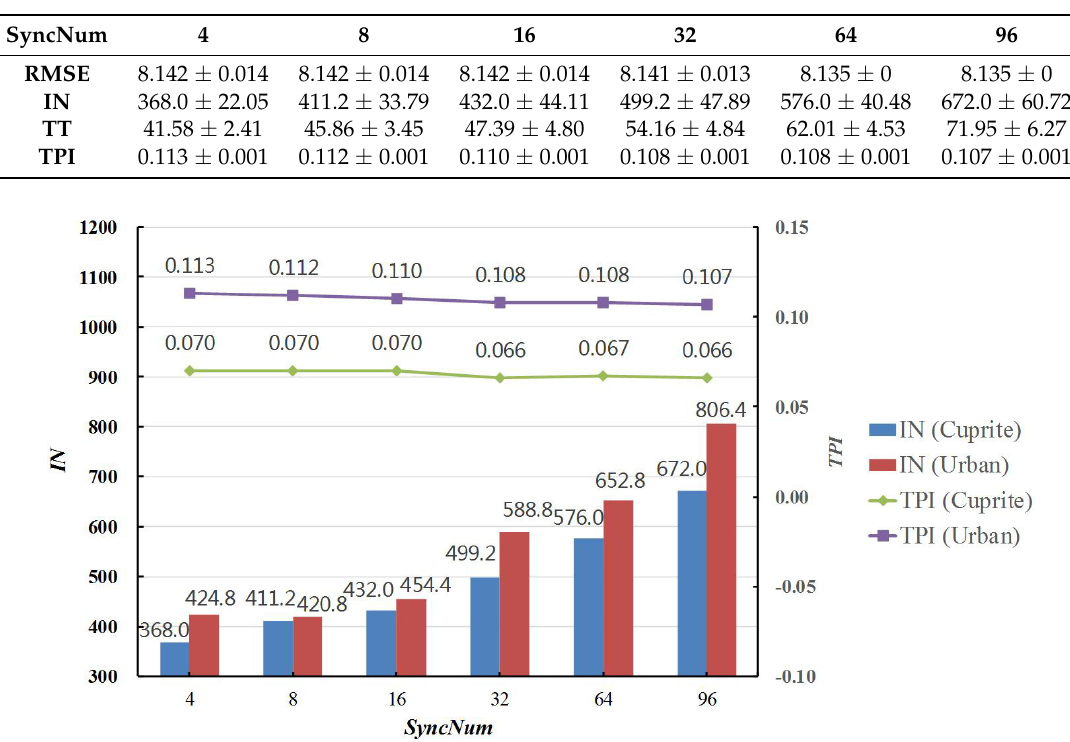
Table 15. Comparison of different SyncNum in MG-ACOEE on the parallel performance for Urban data.